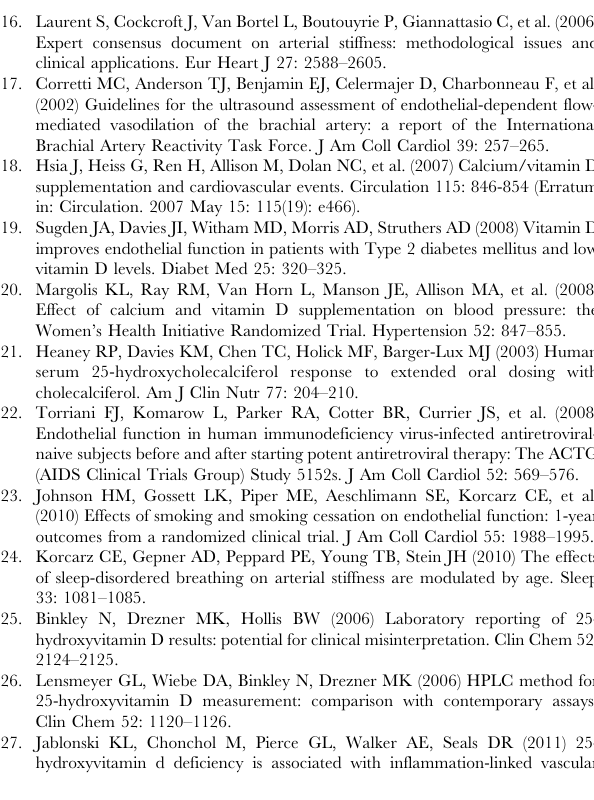
Protocol S1 Trial Protocol. Effect of Vitamin D Status on Endothelial Function. Table S1 Unadjusted Changes from Baseline after 4 Months Stratified by Baseline Vitamin D